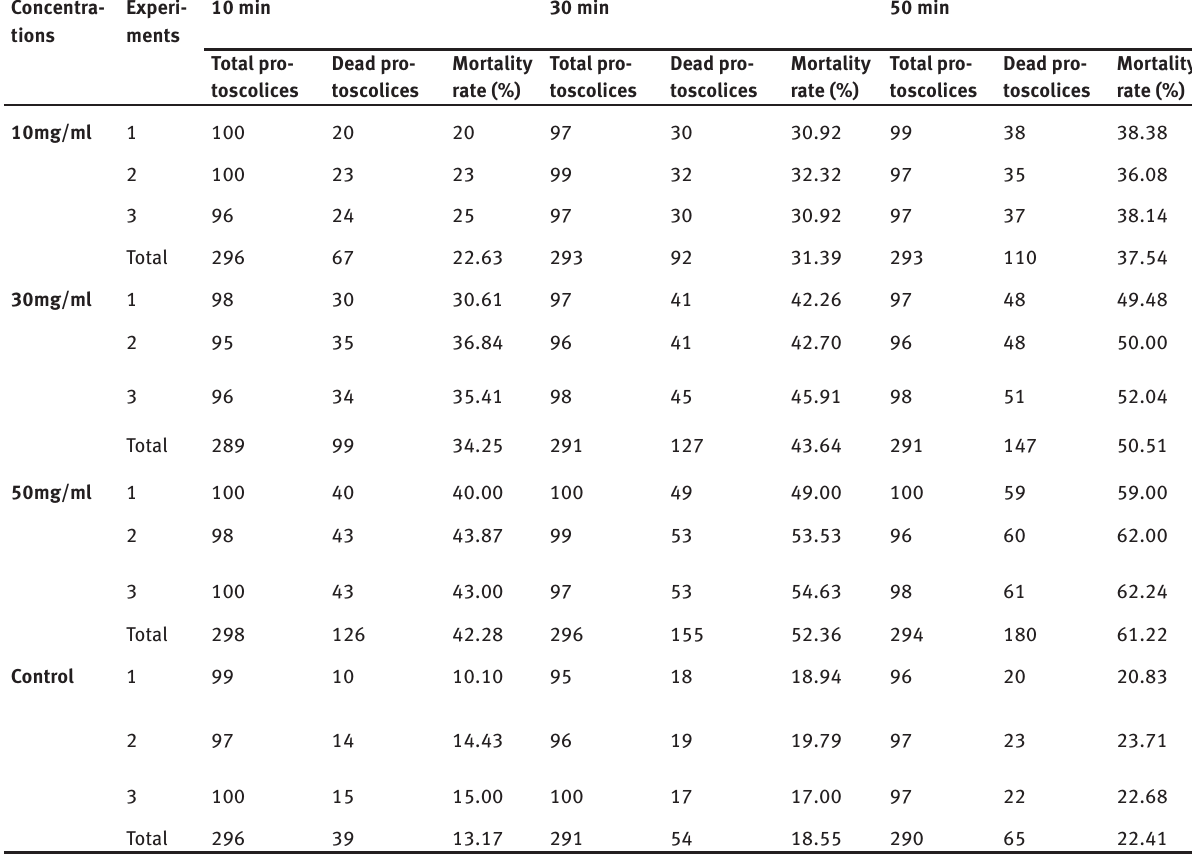
Table 4: Antiprotoscolices effect of E.heliscopia extracts at different concentrations and exposure times. Concentra- tions